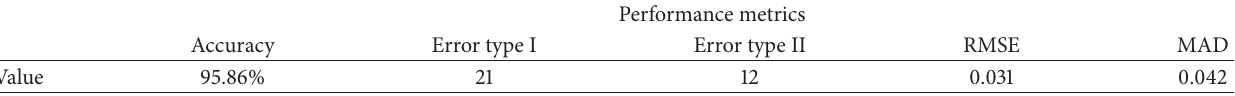
Table 8: Performance metrics of 𝛼 -FCM + ANN + Cox hierarchical